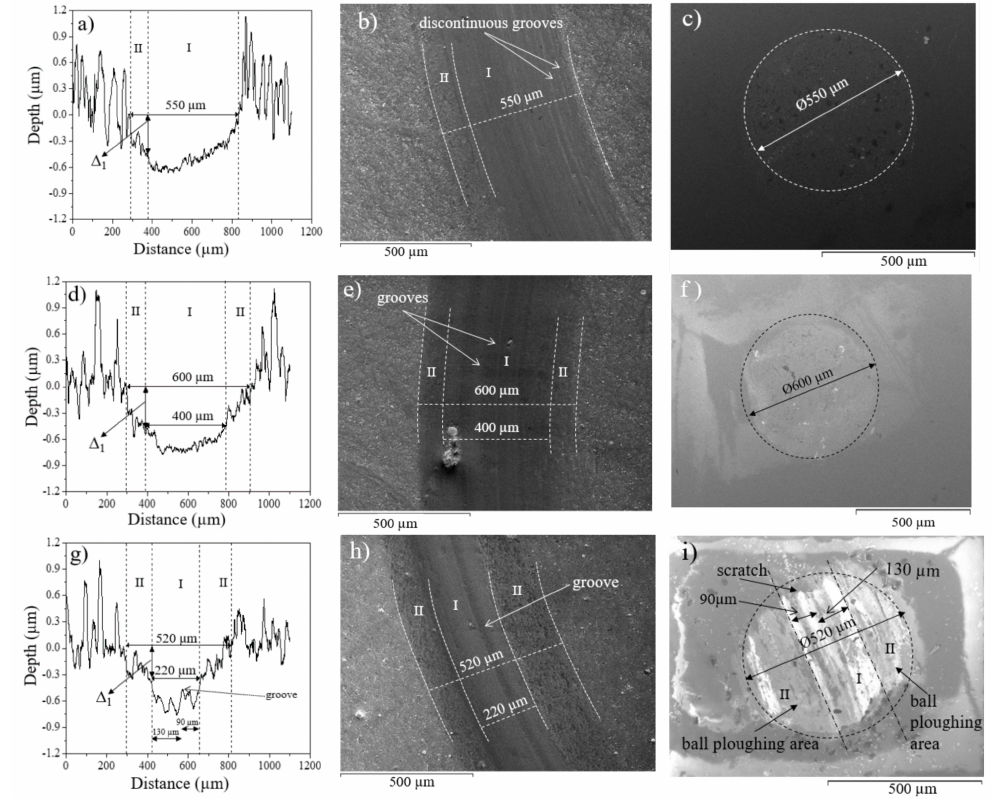
Figure 3. Wear scar depth profiles on the coating and alumina balls after sliding tests: ( a – c ) RT, ( d – f ) 600 and ( g – i ) 800 ◦ C.